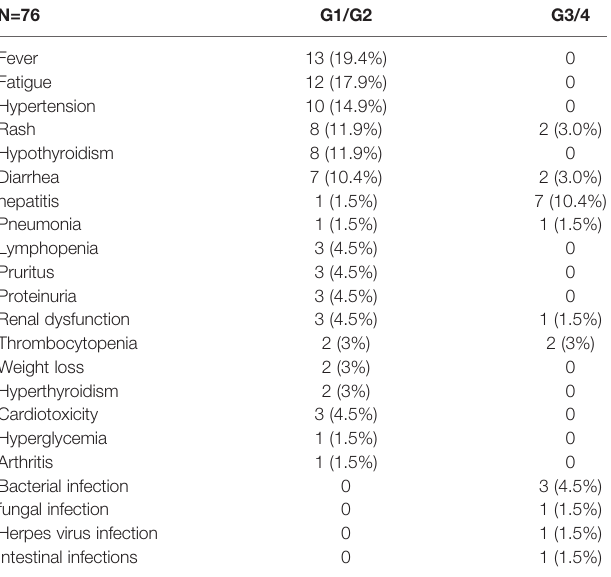
TABLE 2 | Overall incidence of adverse